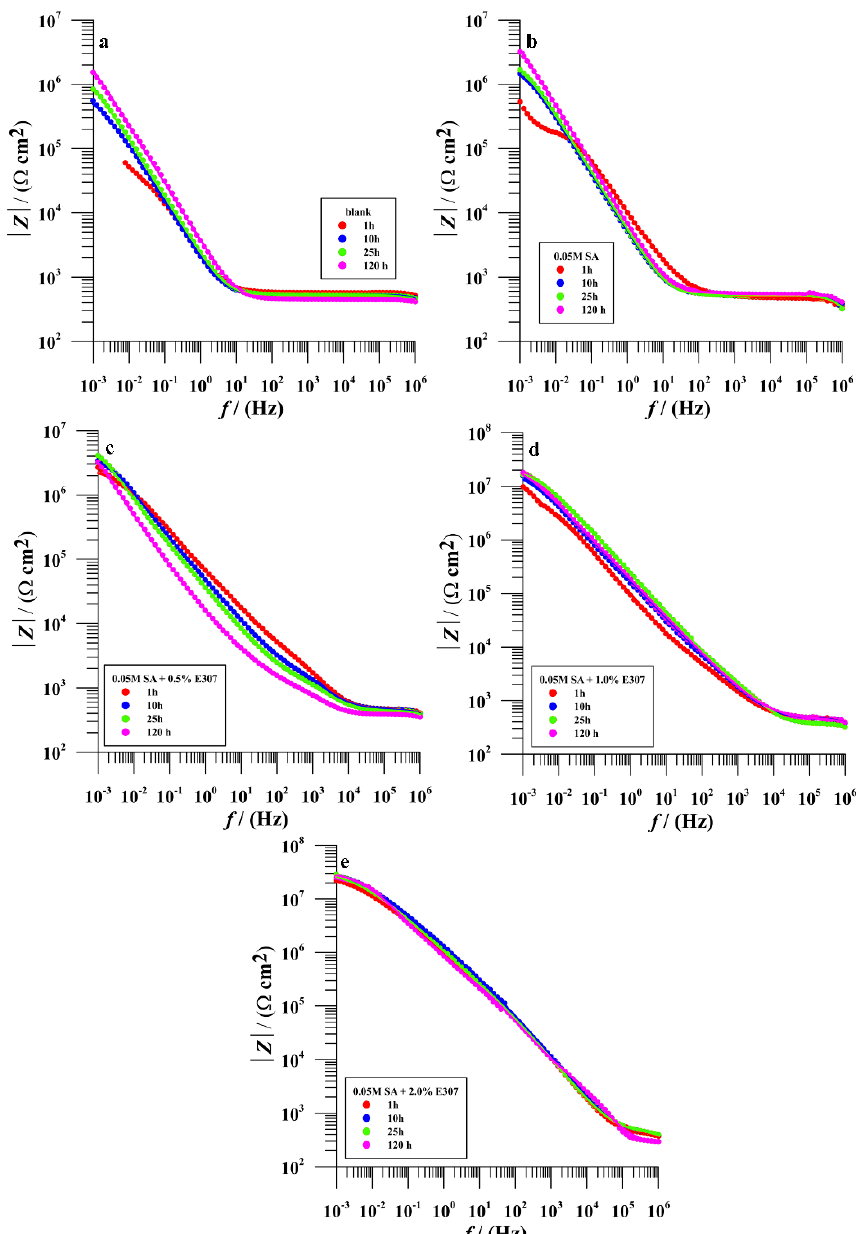
Figure 8. Bode- | Z | -module plots of SS AISI 410S samples for bare and modified surfaces measured after 1, 10, 25, and after 120 h of immersion at their open-circuit potential in a simulated solution of acid rain with pH = 3 at 25 °C: ( a ) Blank, ( b ) SA, ( c ) (SA + 0.5% E307), ( d ) (SA + 1.0% E307) and ( e ) (SA + 2.0% E307) (measured data-dotted symbols and fitted data-solid lines). Surface Modified in Stearic Acid